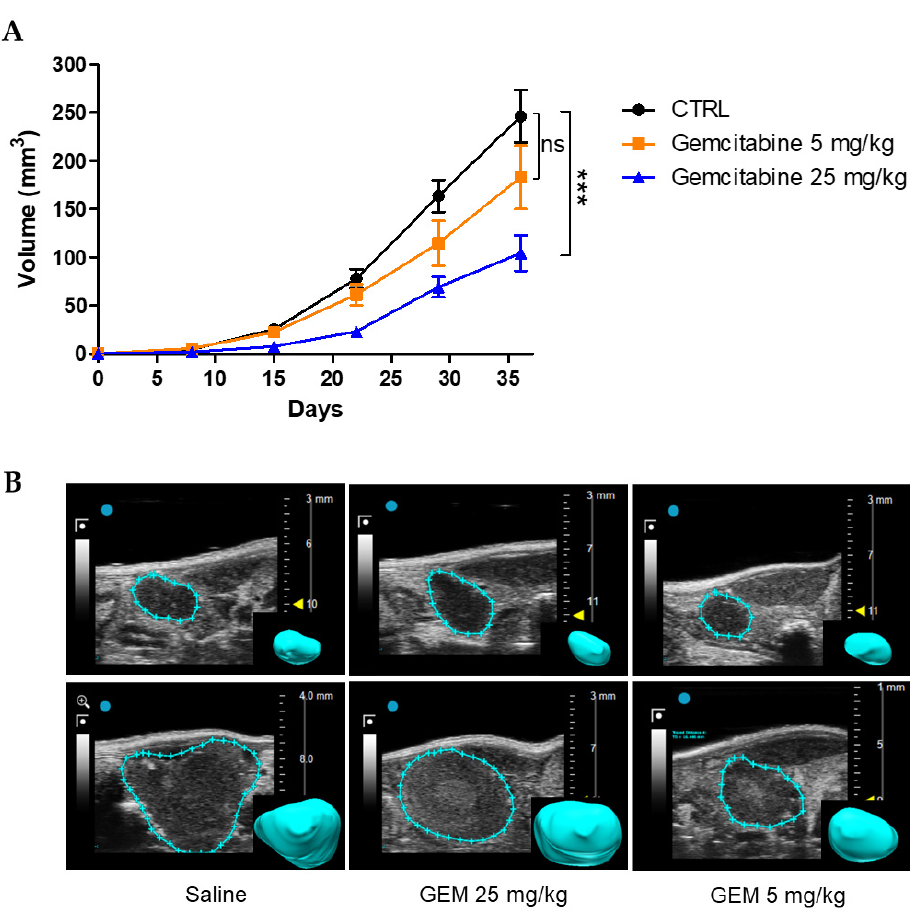
Figure 6. Effects of Gemcitabine in the orthotopic xenograft PDAC mouse model. ( A ) Time course of PDAC tumour growth in mice treated with saline (CTRL, n = 15) and different doses (25 mg/kg, n = 6 and 5 mg/kg, n = 8) of Gemcitabine. Tumour volume was measured with US imaging at several time points. Control group vs. Gemcitabine 25 mg/kg: p = 0.0004, and control group vs. Gemcitabine 5 mg/kg: p = 0.16, for Student’s t test on tumour volume at day 36. ( B ) Representative high-resolution US images of tumour masses at the beginning of the treatment (upper panels) and at the experimental end point (lower panels). The rendered 3D images of the tumour masses are shown in the insets. Data are presented as mean values ± s.e.m. *** p < 0.001; n.s.: not statistically